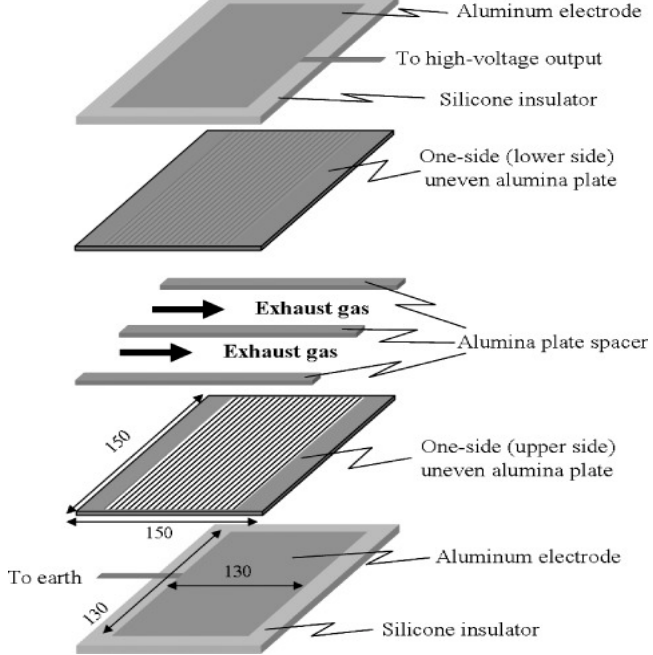
Figure 9. The basic structure of an inhomogeneous DBD reactor [117].